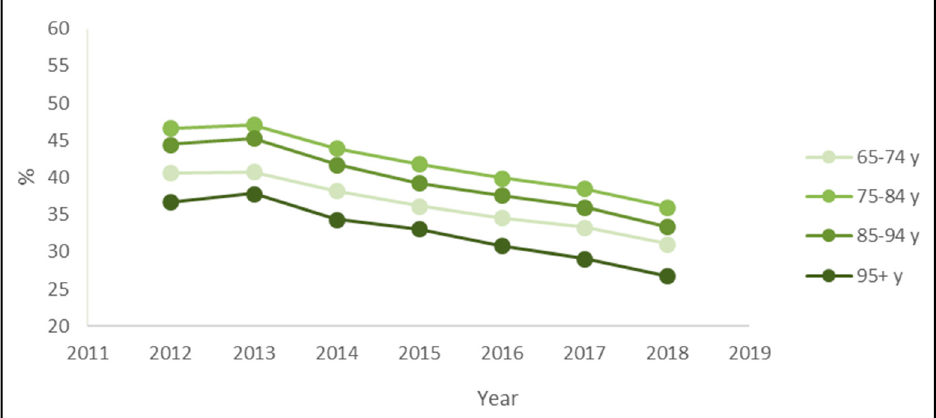
Figure 3. Prevalence of exposure to at least one potentially inappropriate prescription among the drugs’ users by the age classes of outpatients older than 65 years in Piedmont in the period 2012– 2018.